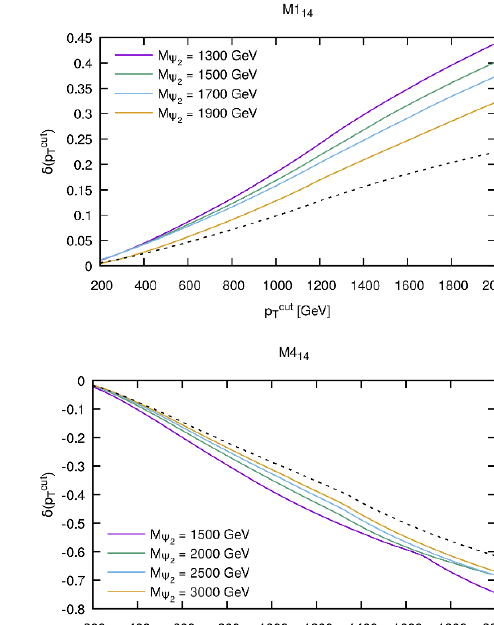
) for benchmark scenario 1 and the four models considered in T